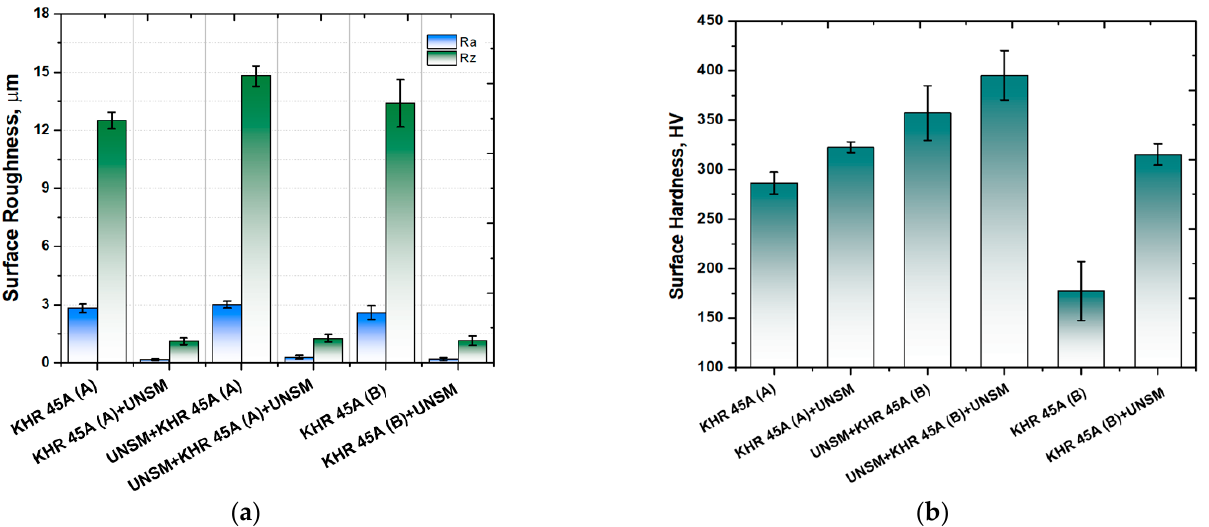
Figure 4. Comparison of surface roughness ( a ) and surface hardness ( b ) of the carburized, pre-, and post-carburized UNSM-treated KHR 45A steels.